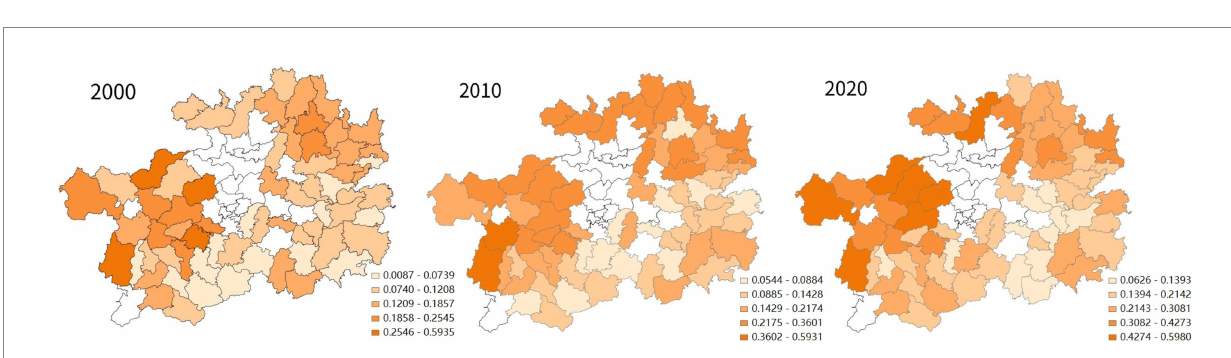
FIGURE 8 Spatial analysis of social QoL changes in districts and counties of Guizhou